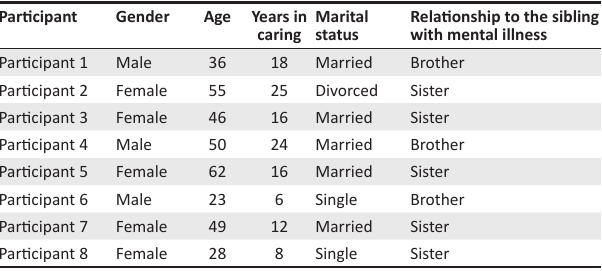
TABLE 1: Participants’ demographics.